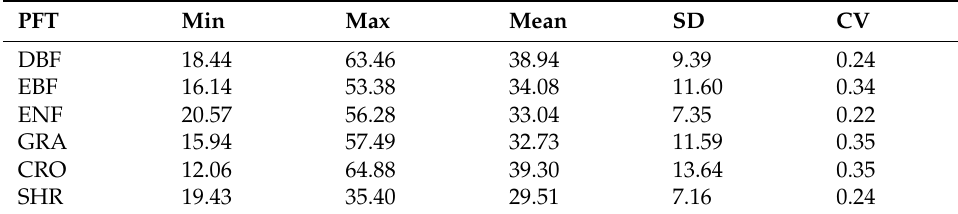
Table 3. Summary statistics of the field measured LCC ( µ g cm − 2